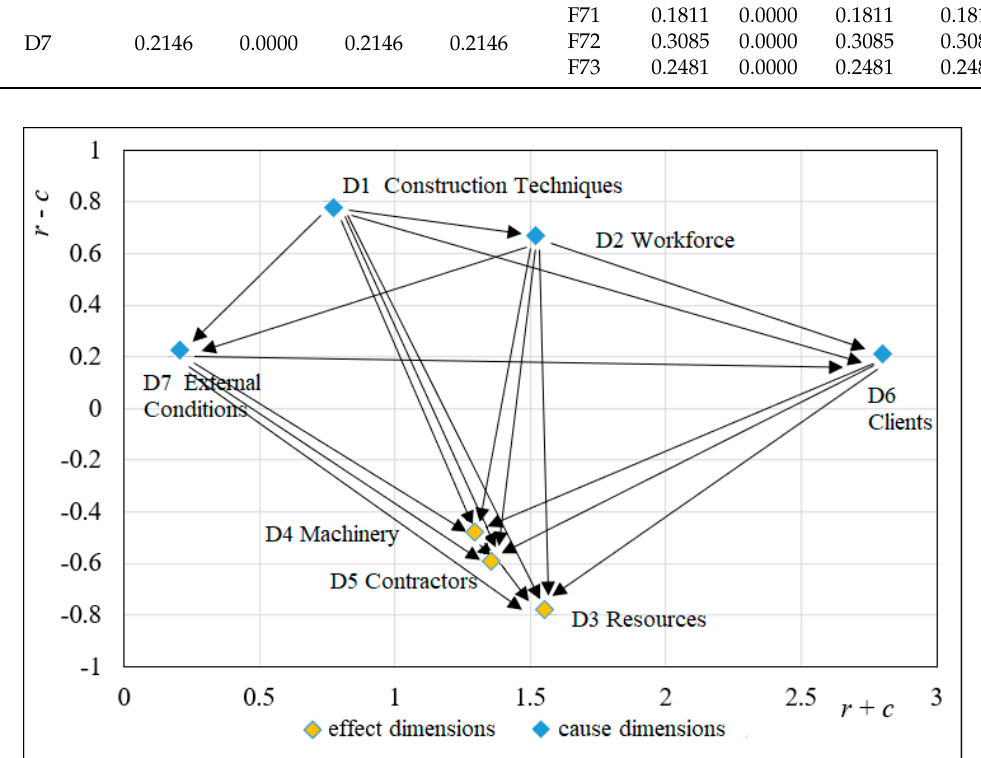
Figure 2. Influential network-relationship map for dimensions.